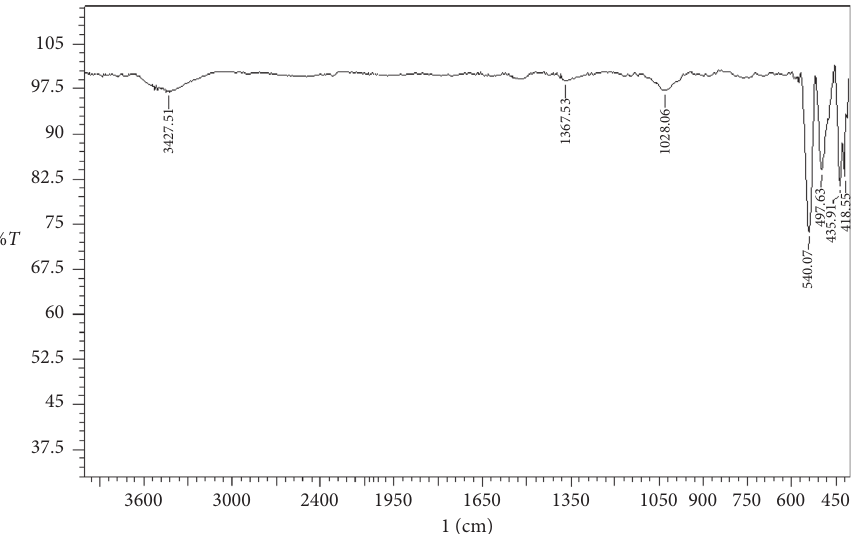
Figure 10: Infrared spectrum of